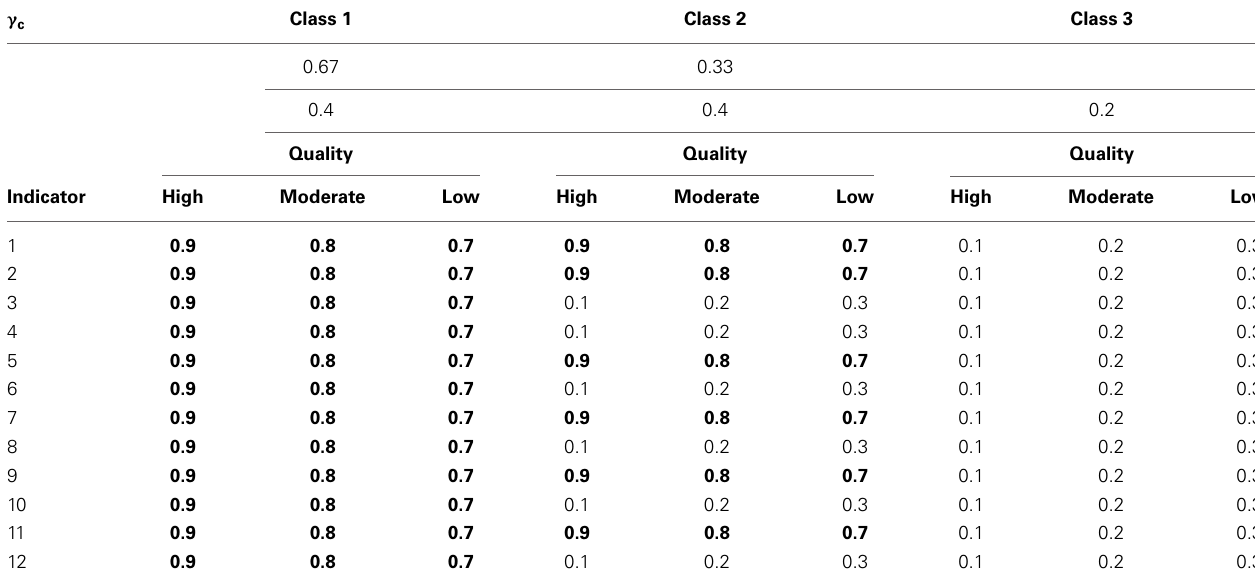
Table 1 | Summary of population specifications for class proportions, class profiles, and indicator quality (as